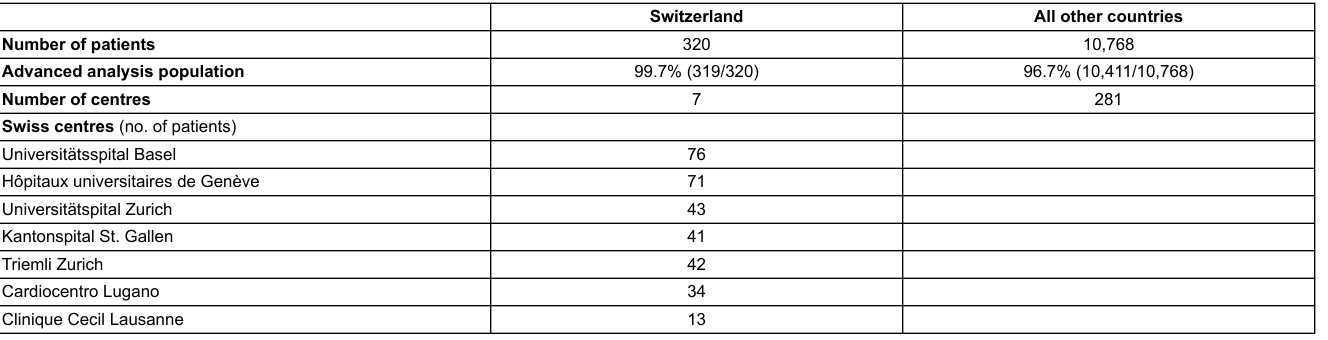
Table 1: Analysis overview and participating centres in